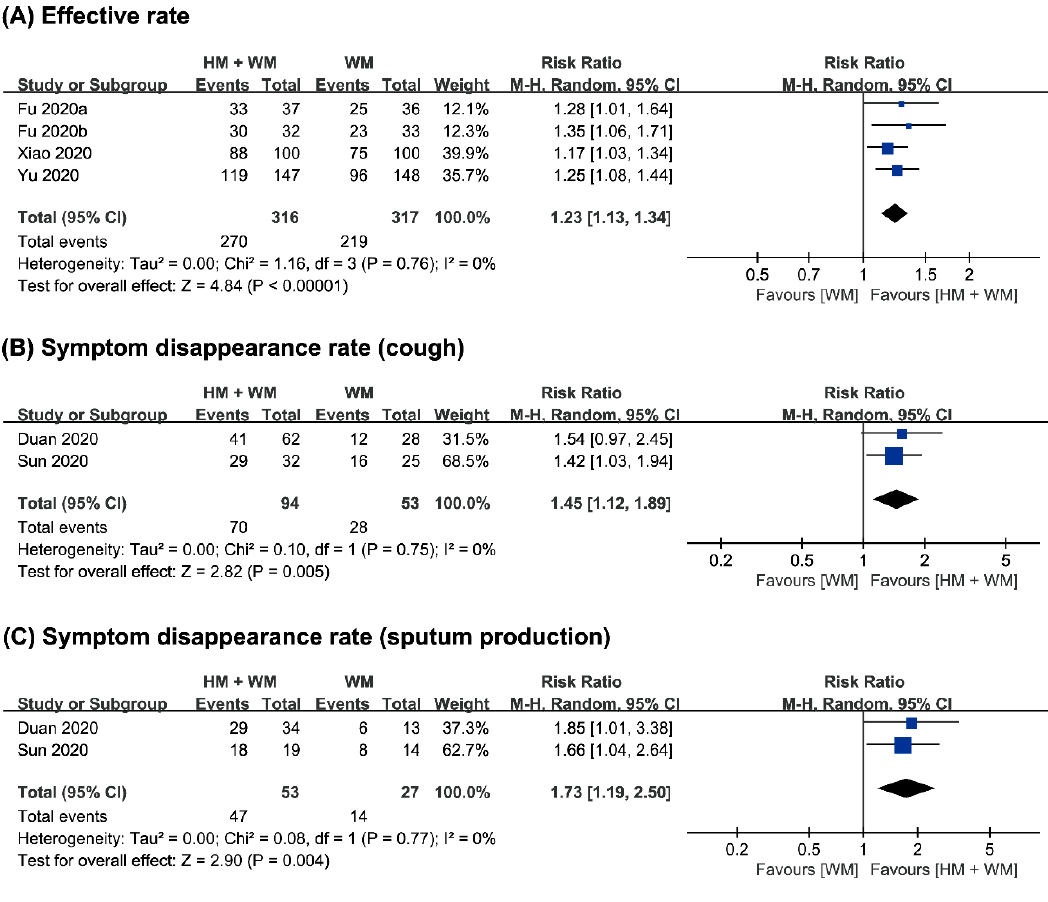
Figure3. ComparisonofherbalmedicineandWesternmedicine(HM + WM)vs. Westernmedicine(WM) Figure 3. Comparison of herbal medicine and Western medicine (HM + WM) vs. Western medicine on ( A ) the total e ff ective rate; ( B ) symptom disappearance rate of cough; and ( C ) sputum (WM) on ( A ) the total effective rate; ( B ) symptom disappearance rate of cough; and ( C ) sputum production.